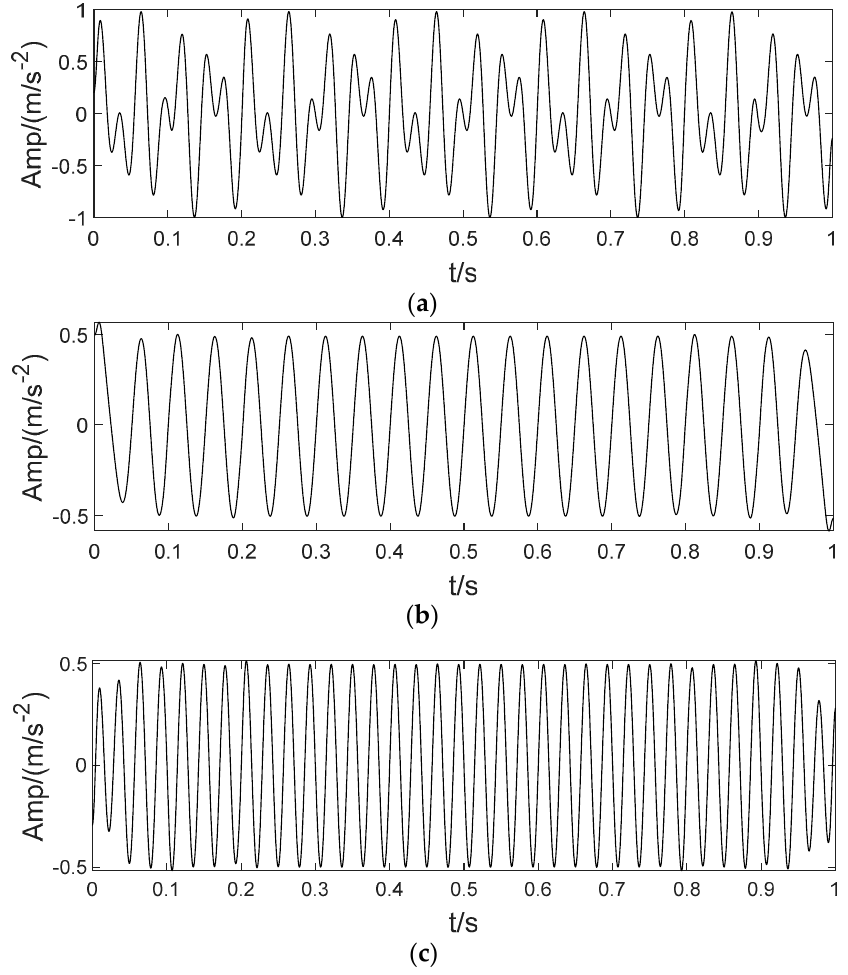
Figure 10. The second IMF component obtained by decomposition.